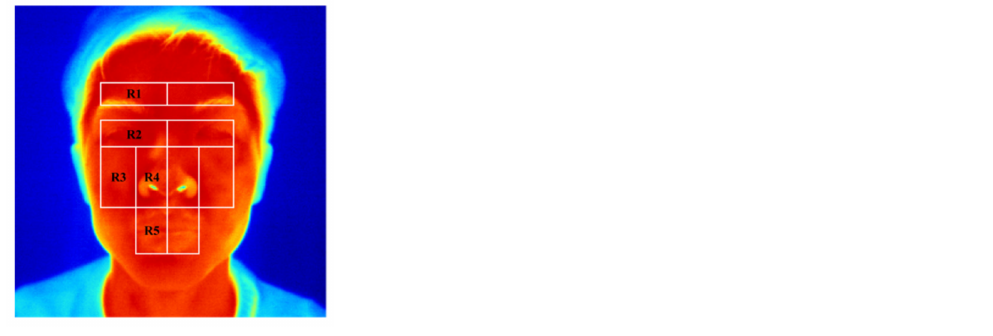
Figure 2. Illustration of facial ROIs. R1: forehead region; R2: orbital region; R3: infraorbital region; R4: nasal region, R5: mouth region. Table 2. Automatic segmentation algorithm of facial